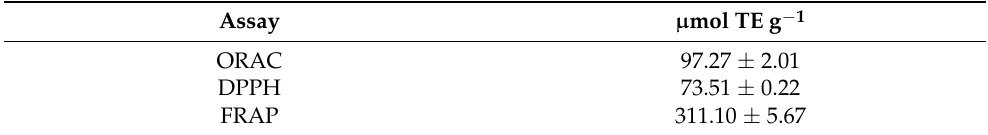
Table 4. Antioxidant activity of laurel extracts obtained by PLE determined by various